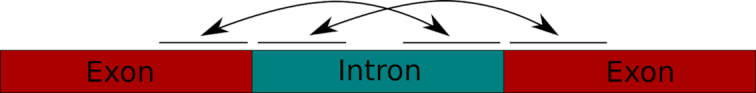
Calculating the hamming distinct of both the right-most region of the left anchor to the right-most region of the intron and the left-most region of the intron to the left-most region of the right anchor can give an indication of whether the splice site may have been incorrectly triggered by a repeat region in the genome.